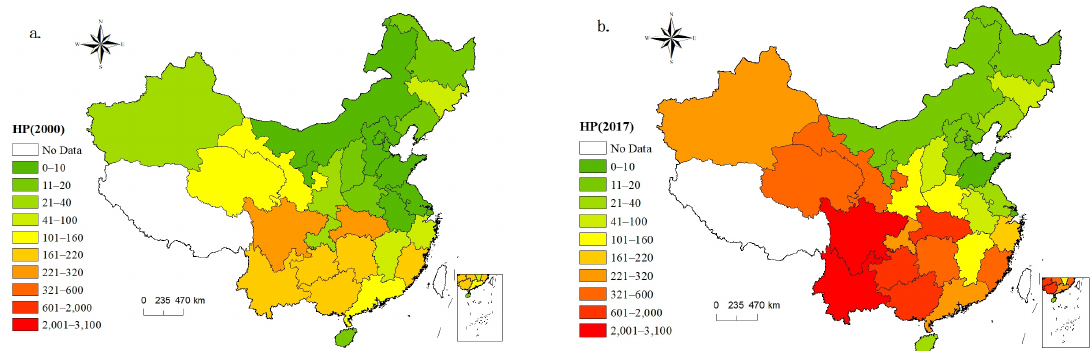
Figure 2. The temporal and spatial distribution of hydropower generation (100 million kWh) in China’s provinces: ( a ) spatial distribution of hydropower generation in 2000; ( b ) spatial distribution of hydropower generation in 2017.